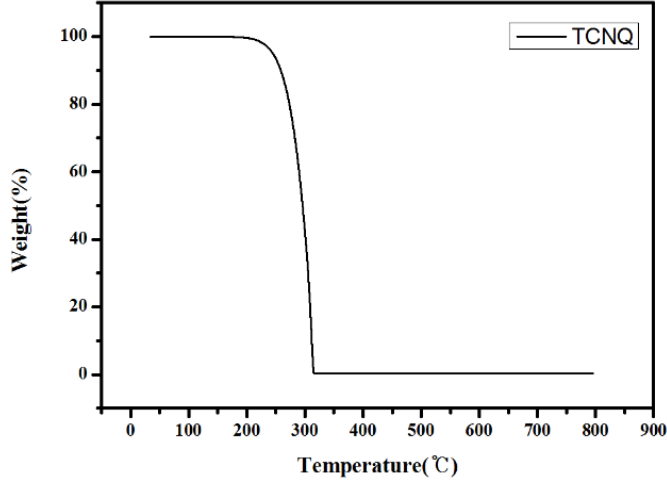
Figure 5. TGA curve of TCNQ from 100 to 600 °C.